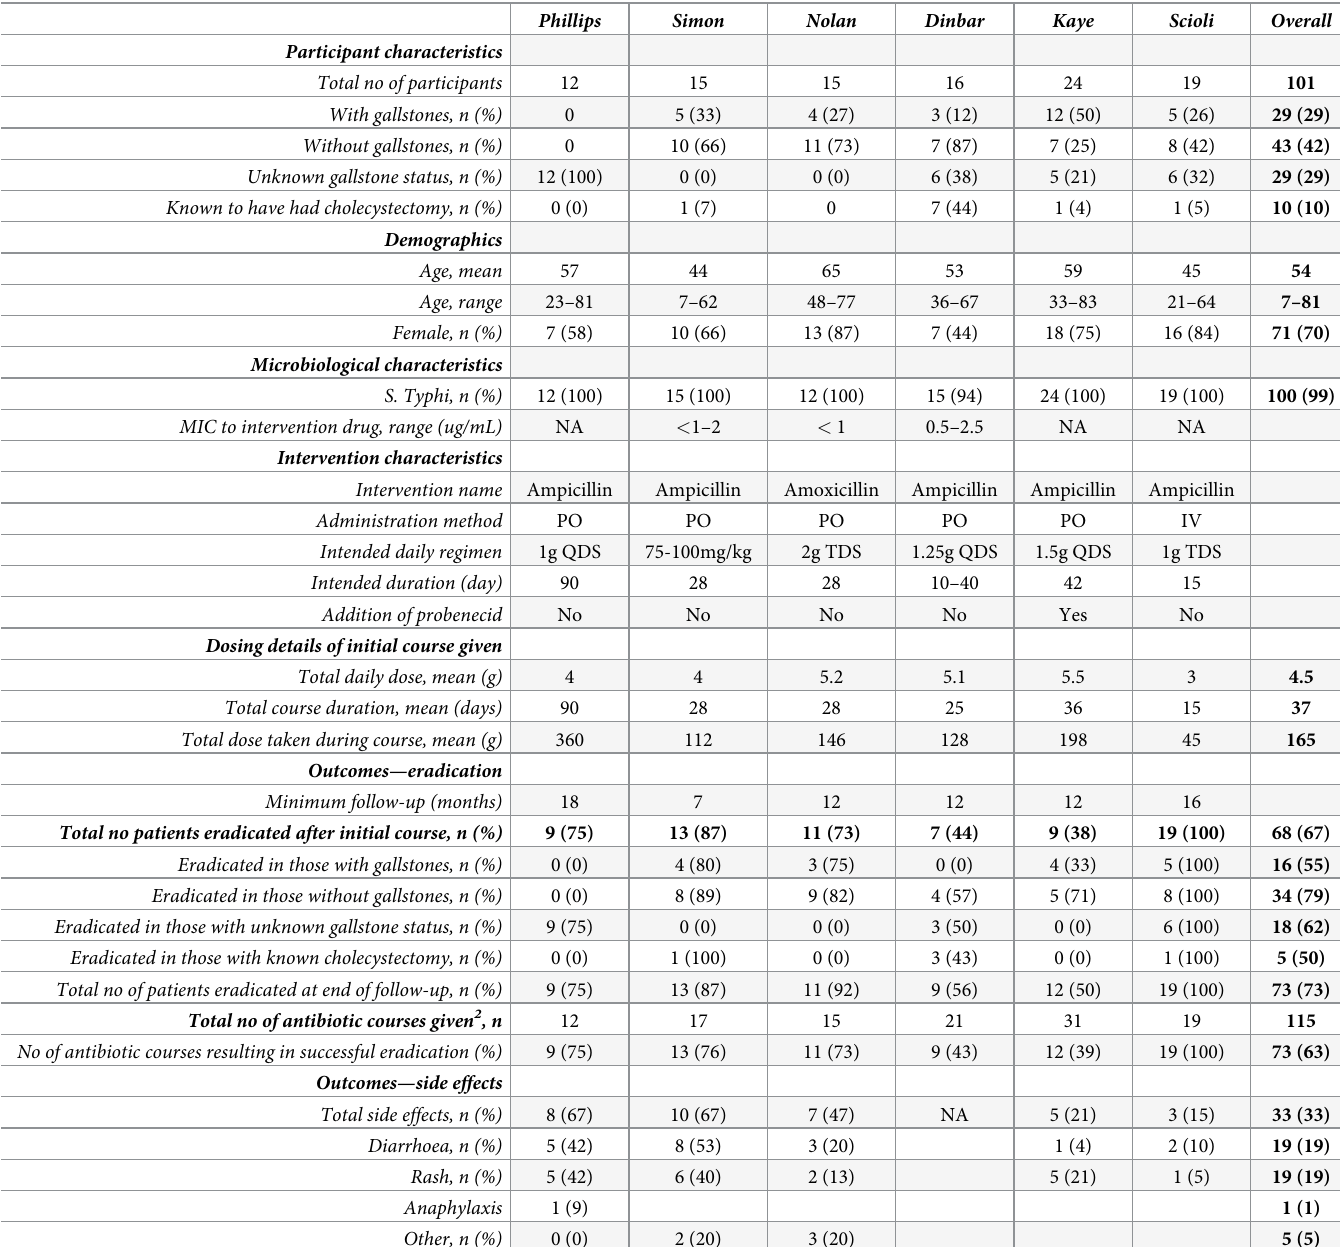
Table 3. Summary of results from studies using amoxicillin or ampicillin to treat enteric fever chronic carriage.